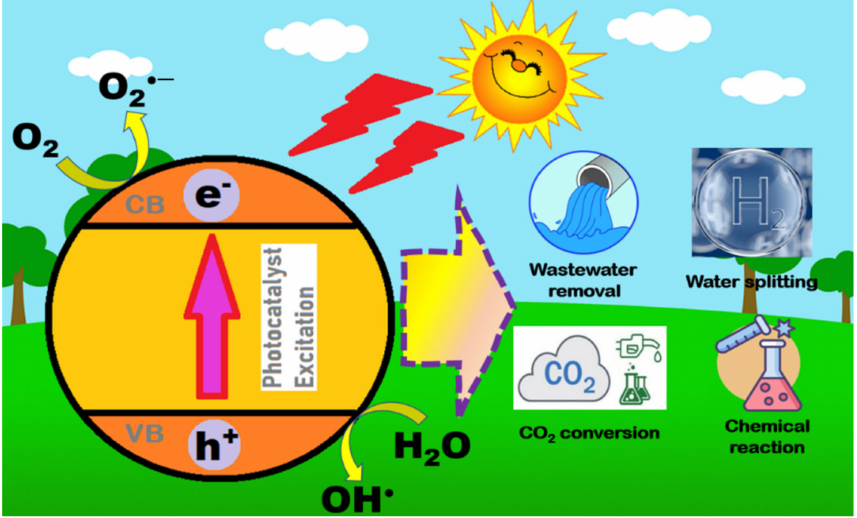
Figure 1. The mechanism of the photocatalytic process and its